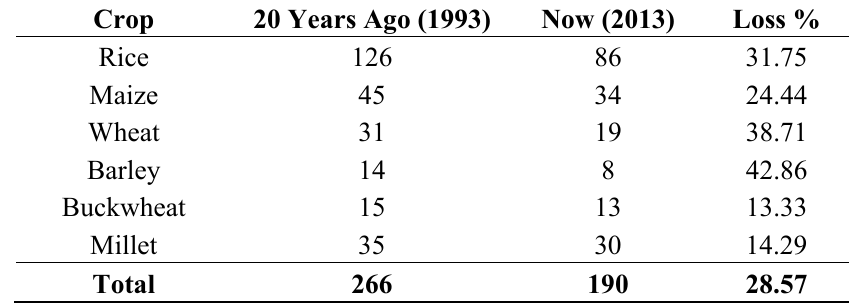
Table 3. Status of traditional varieties of cereals cultivated 20 years ago and now.